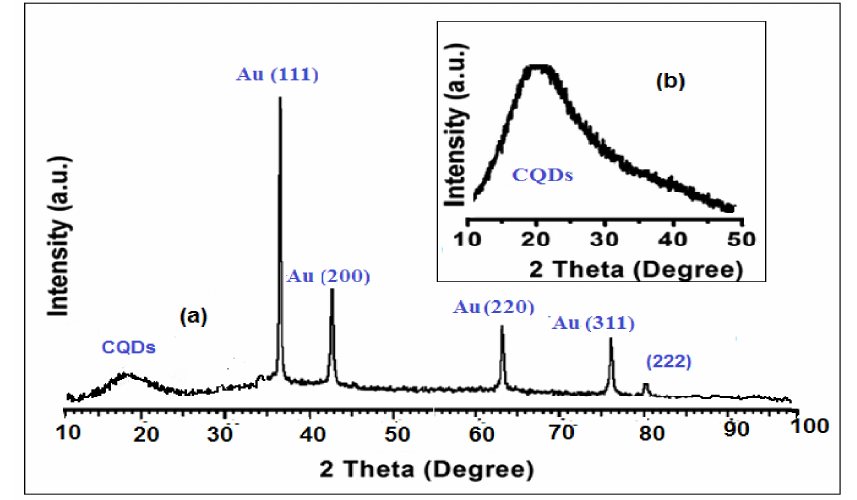
Figure 5. XRD pattern of ( a ) CQDs and ( b ) CQDs/Au